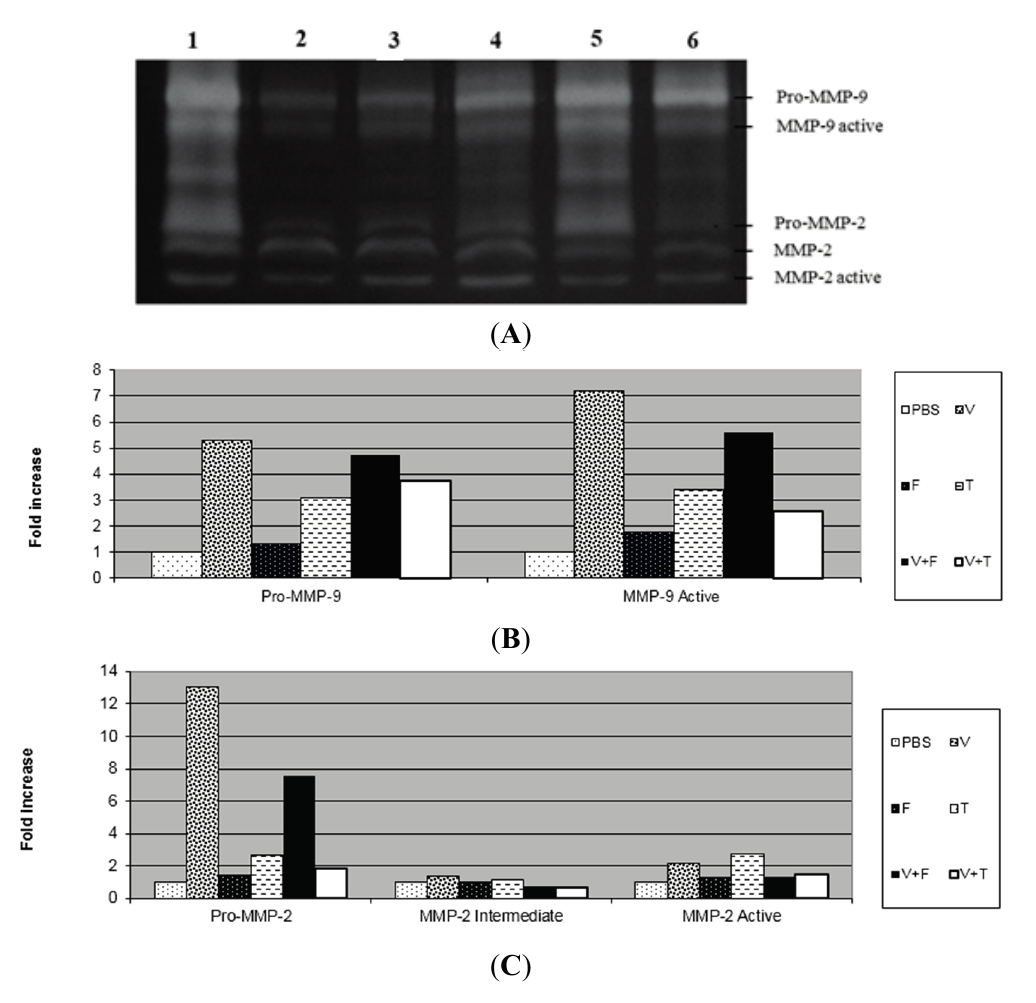
Figure 3. Effect of the tannin and flavonoid fractions from Davilla elliptica on the gelatinolytic activity of MMP-2 and MMP-9 in mouse dermis. ( A ) The gelatinolytic activity of MMP-2 and MMP-9: Venom (V) (lane 1); PBS (lane 2); Flavonoids fraction (F) (lane 3); Tannins fraction (T) (lane 4); Venom + flavonoids fraction (V + F) (lane 5); Venom + tannins fraction (V + T) (lane 6); ( B ) The gelatinolytic activity of MMP-9 by integrated optical density (IOD); ( C ) The gelatinolytic activity of MMP-2 by integrated optical density (IOD). The results are presented as fold